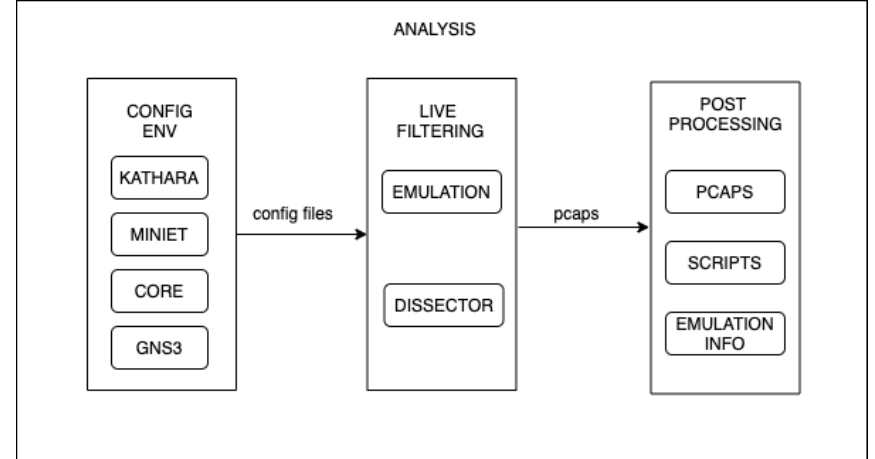
Figure 4. Analysis